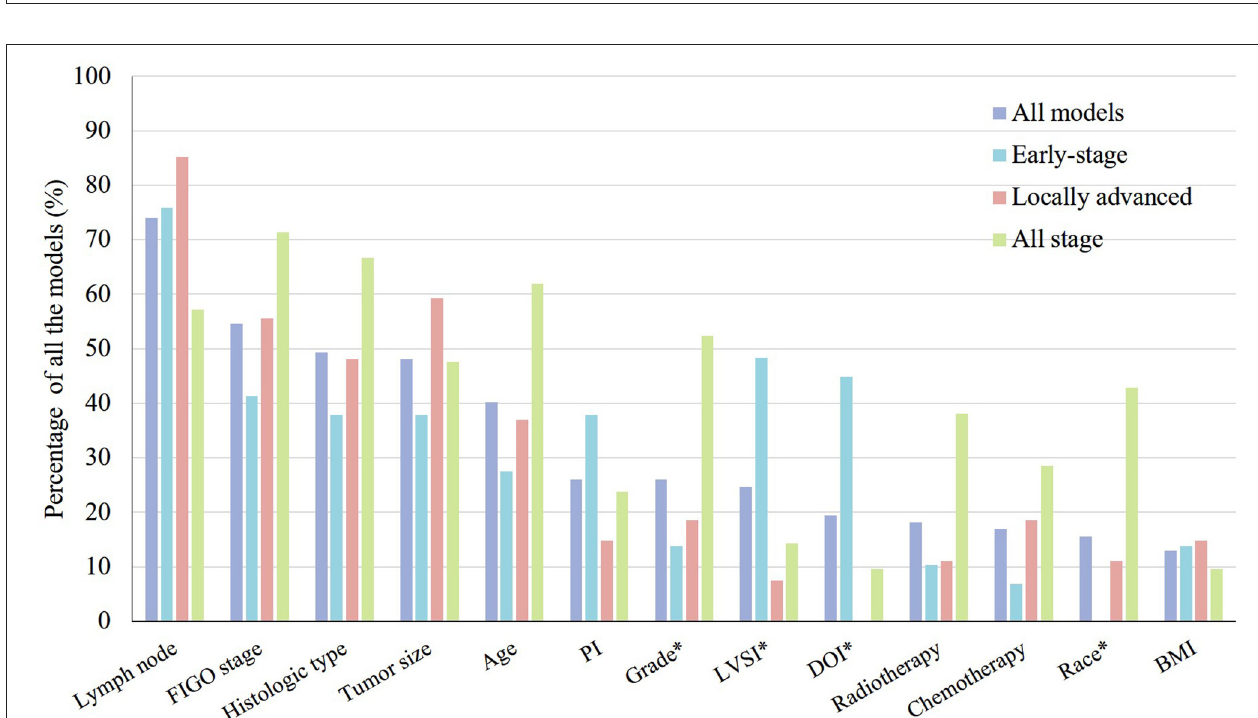
FIGURE 2 | Thirteen most frequently used predictors in 77 prognostic models for the prognosis of cervical cancer patients presented by clinical stage. PI, parametrium invasion; LVSI, lymph vascular space invasion; DOI, depth of stromal invasion; BMI, body mass index. * p < 0.05.